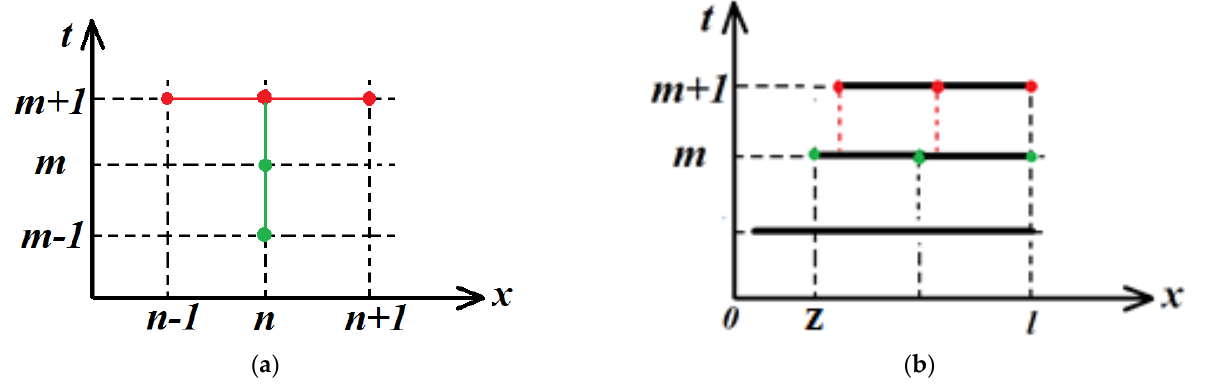
Figure 2. ( a ) difference scheme template, ( b ) illustration of the interpolation procedure. The red nodes of the grid are located on a new time layer, the values of the functions in them are to be determined. Green nodes are on the current or past time layer, the values of the functions in them are already known.